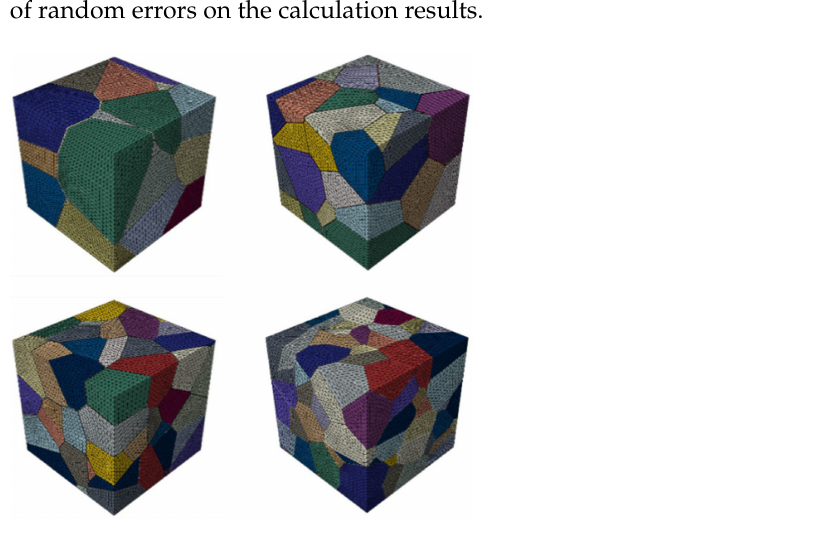
Figure 12. Finite element model of polycrystals with grain numbers of 25, 50, 100, and